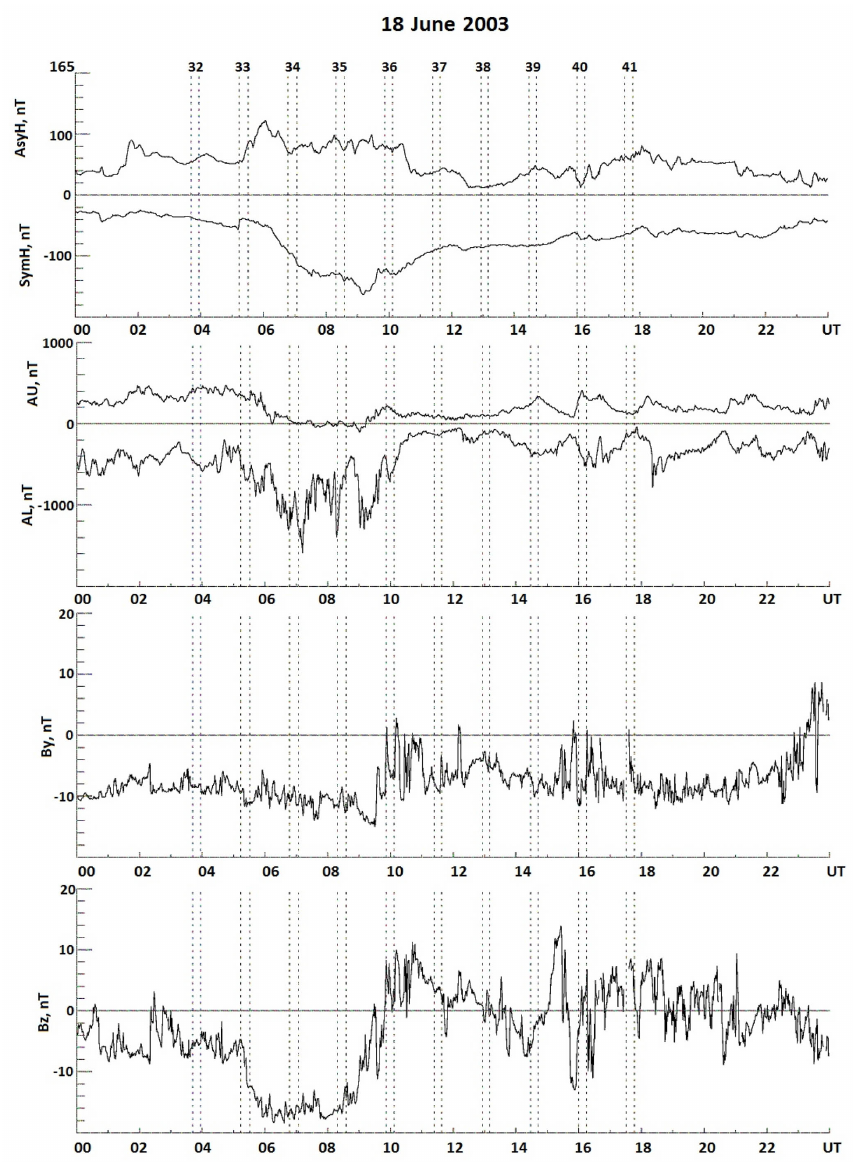
Figure A3. One-minute values of the AsyH, SymH, AU, and AL indices and of the B y and B z components of the IMF for the storm on 18 June 2003 (analyzed interval from 03:00–18:00UT, orbits 16532–16541). The time of each orbit and its orbit number are indicated as in Fig. 1 of the